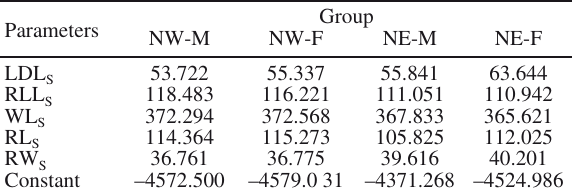
Fig. 4. – Canonical discriminant plots of standardized statolith mor- phological variables of samples in each sex from the two stocks in the North Pacific Ocean. Table 7. – Coefficients of parameters in classification functions us- ing statoliths as a